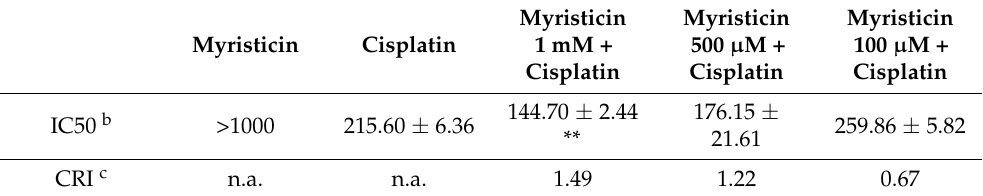
Table 1. Cytotoxic activity expressed as IC50 ( µ M) of myristicin and cisplatin and their association in the NCI/ADR-RES a lineage after 48 h of exposure.